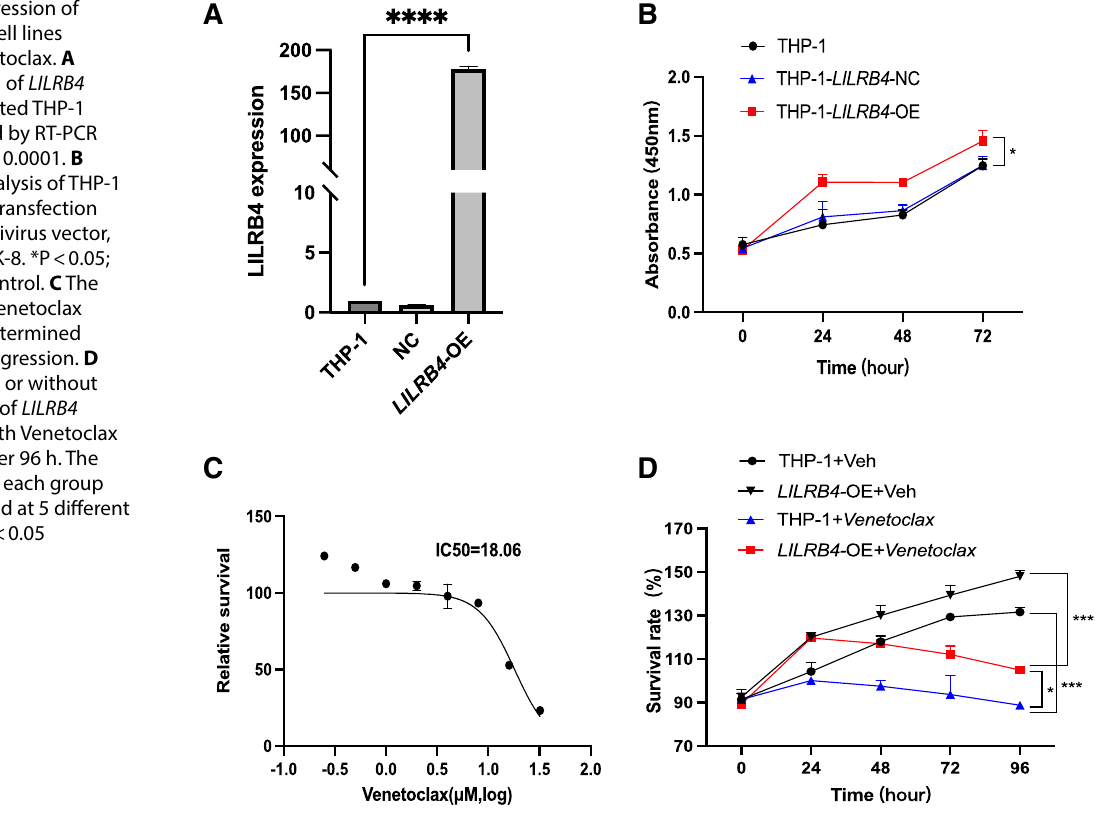
Fig. 7 Overexpression of LILRB4 in AML cell lines treated by Venetoclax. A Expression level of LILRB4 in virus transfected THP-1 was determined by RT-PCR analysis. ****P < 0.0001. B Proliferation analysis of THP-1 cells following transfection with LILRB4 lentivirus vector, assessed by CCK-8. *P < 0.05; NC, negative control. C The IC-50 value of Venetoclax in THP-1 was determined by non-linear regression. D THP-1 cells with or without overexpression of LILRB4 were treated with Venetoclax (18.06 μmol) over 96 h. The survival rates of each group were determined at 5 different time points. *P <